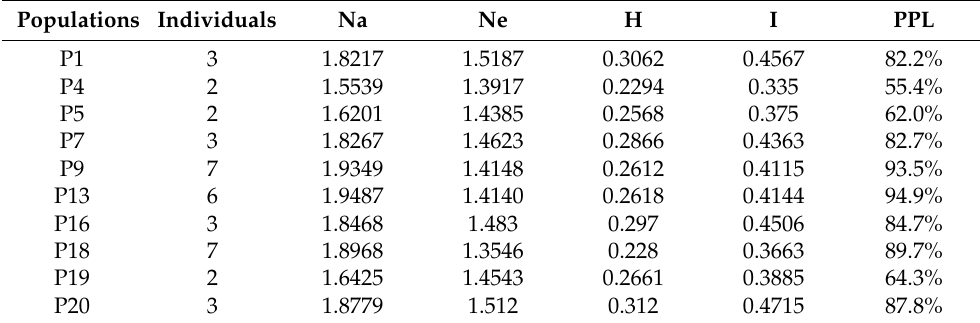
Table 1. Genetic diversity of Eleutharrhena macrocarpa populations. Populations Individuals